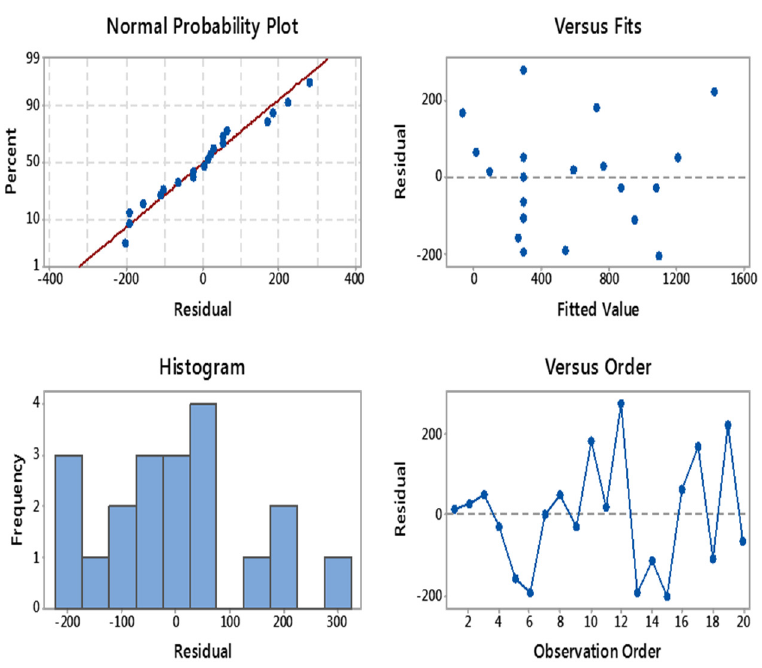
Figure 2. The distribution of the residuals of the central composite design model.